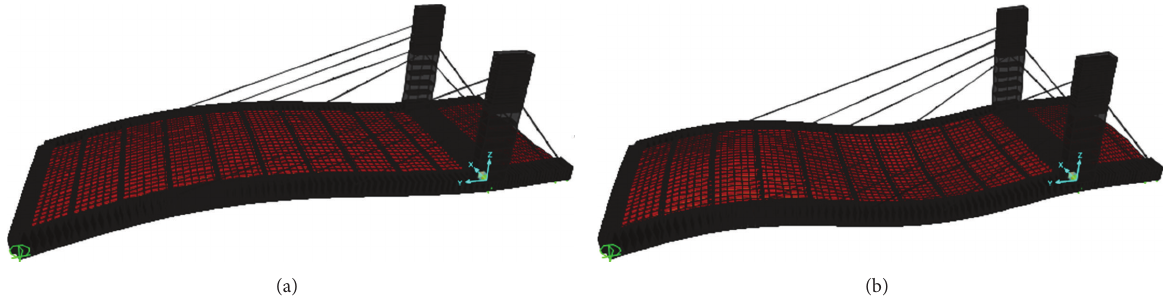
Figure 34: Mathematically identified mode shapes: (a) 1st mode; (b) 2nd